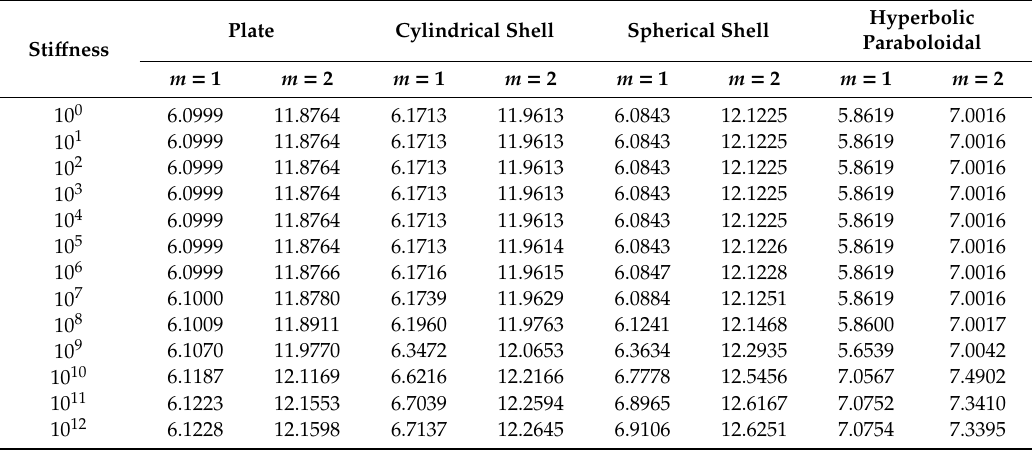
Table 12. The frequency parameter Ω for composite shallow [0 ◦ / 90 ◦ ] shells with S- K u boundary conditions by FSDT.